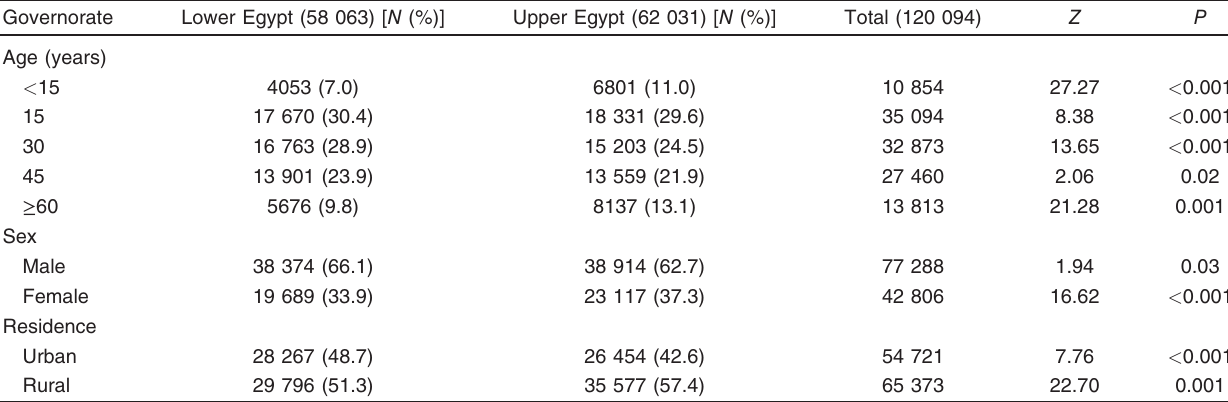
Table 2 Demographic criteria of tuberculosis cases in Lower and Upper Egypt